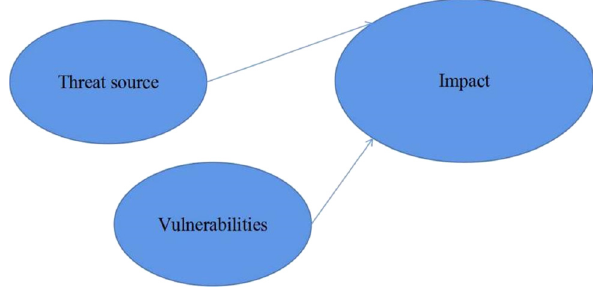
Table 3: Experimental data after